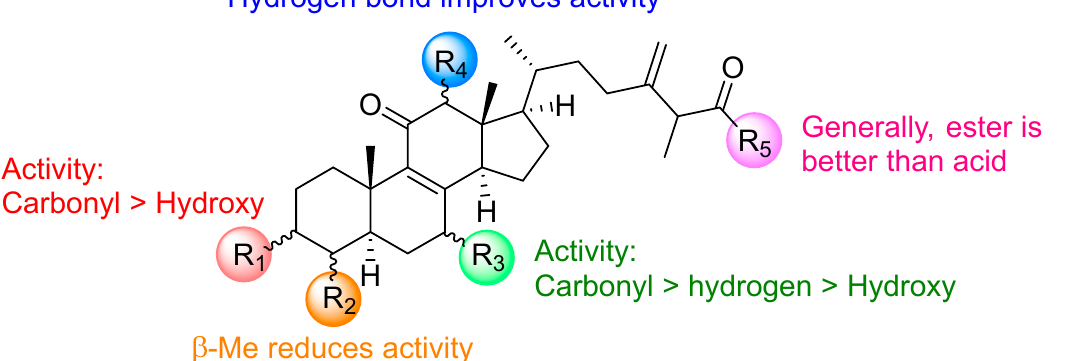
Figure 4. Dose–response curves of compounds 7 – 8 , 11 – 12 , and 25 – 26 in HeLa S3 ( A ) and KBvin ( B ). Figure 5. Summary of the SAR of all triterpenes in terms of collateral sensitivity.